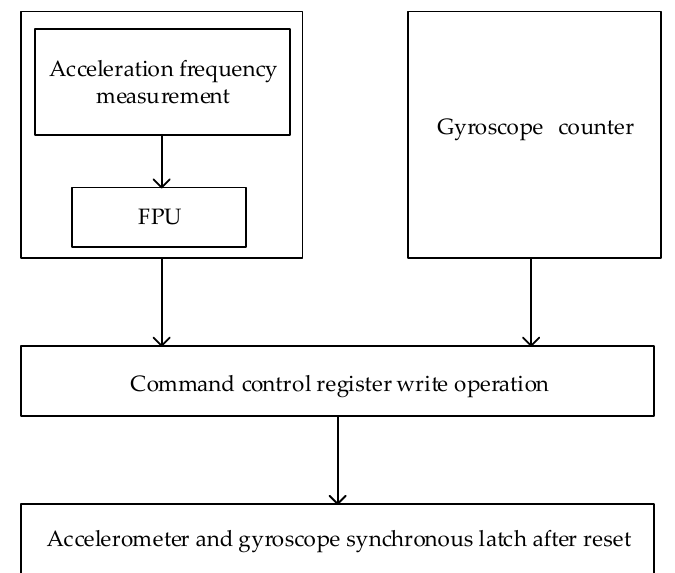
Figure 3. Hardware design of the synchronous data acquisition module.